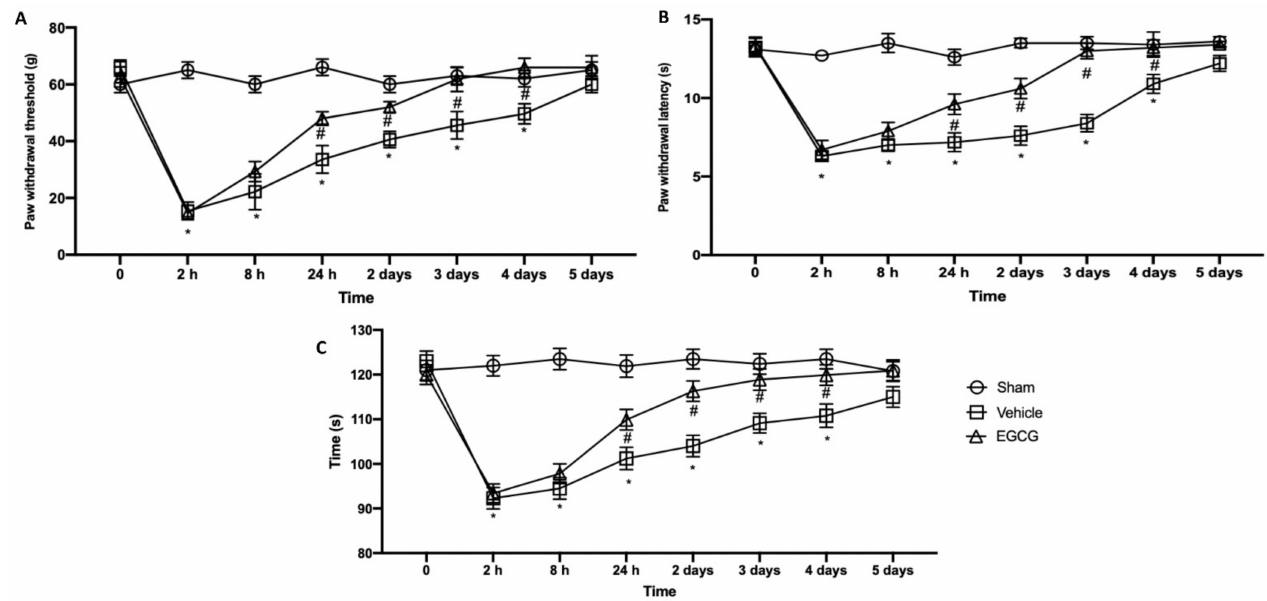
Figure 1. EGCG administration reduced mechanical allodynia, thermal hyperalgesia and motor dysfunction: von Frey test ( A ), plantar test ( B ) and rotarod test ( C ). A p -value of less than 0.05 was considered significant. * p < 0.05 vs. sham, # p < 0.05 vs. vehicle.